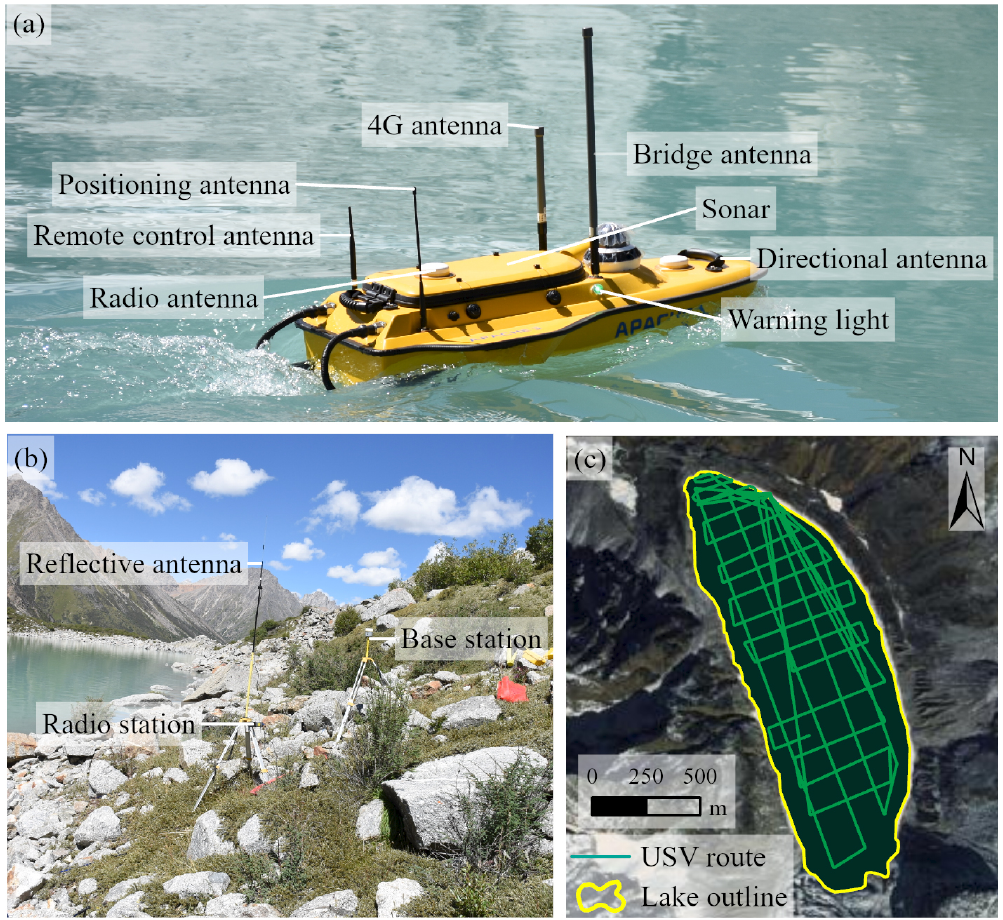
Figure 3. The bathymetry of Bienong Co. (a) The USV sampling equipment in water and (b) on land; (c) the sampling path of the USV in Bienong Co covering the base map of the MapWorld image. Photographs were taken by Xiaojun Yao on 27 August